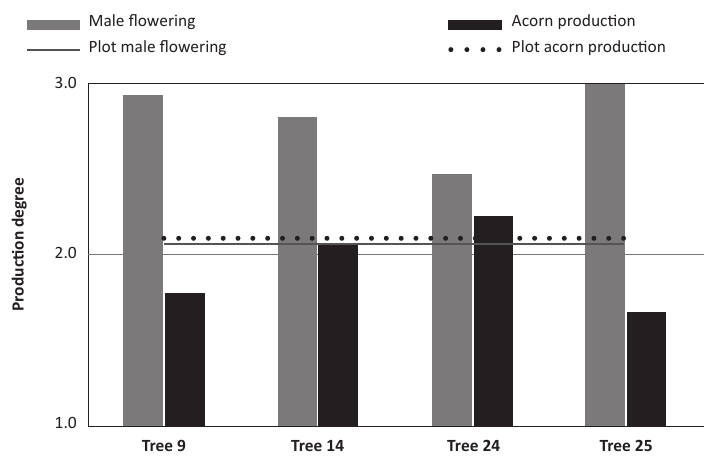
FiGure 1. Male flowering and acorn production of Quercus suber trees selected for the study based on degree rate: degree 1 - null or negligible production of male flowers or fruits; degree 2 - about half of the productive part of the crown exhibits male flowers or fruits; degree 3 - the tree exhibits male flowers or fruits in large quantity. Trees are compared through the mean production from 1993 to